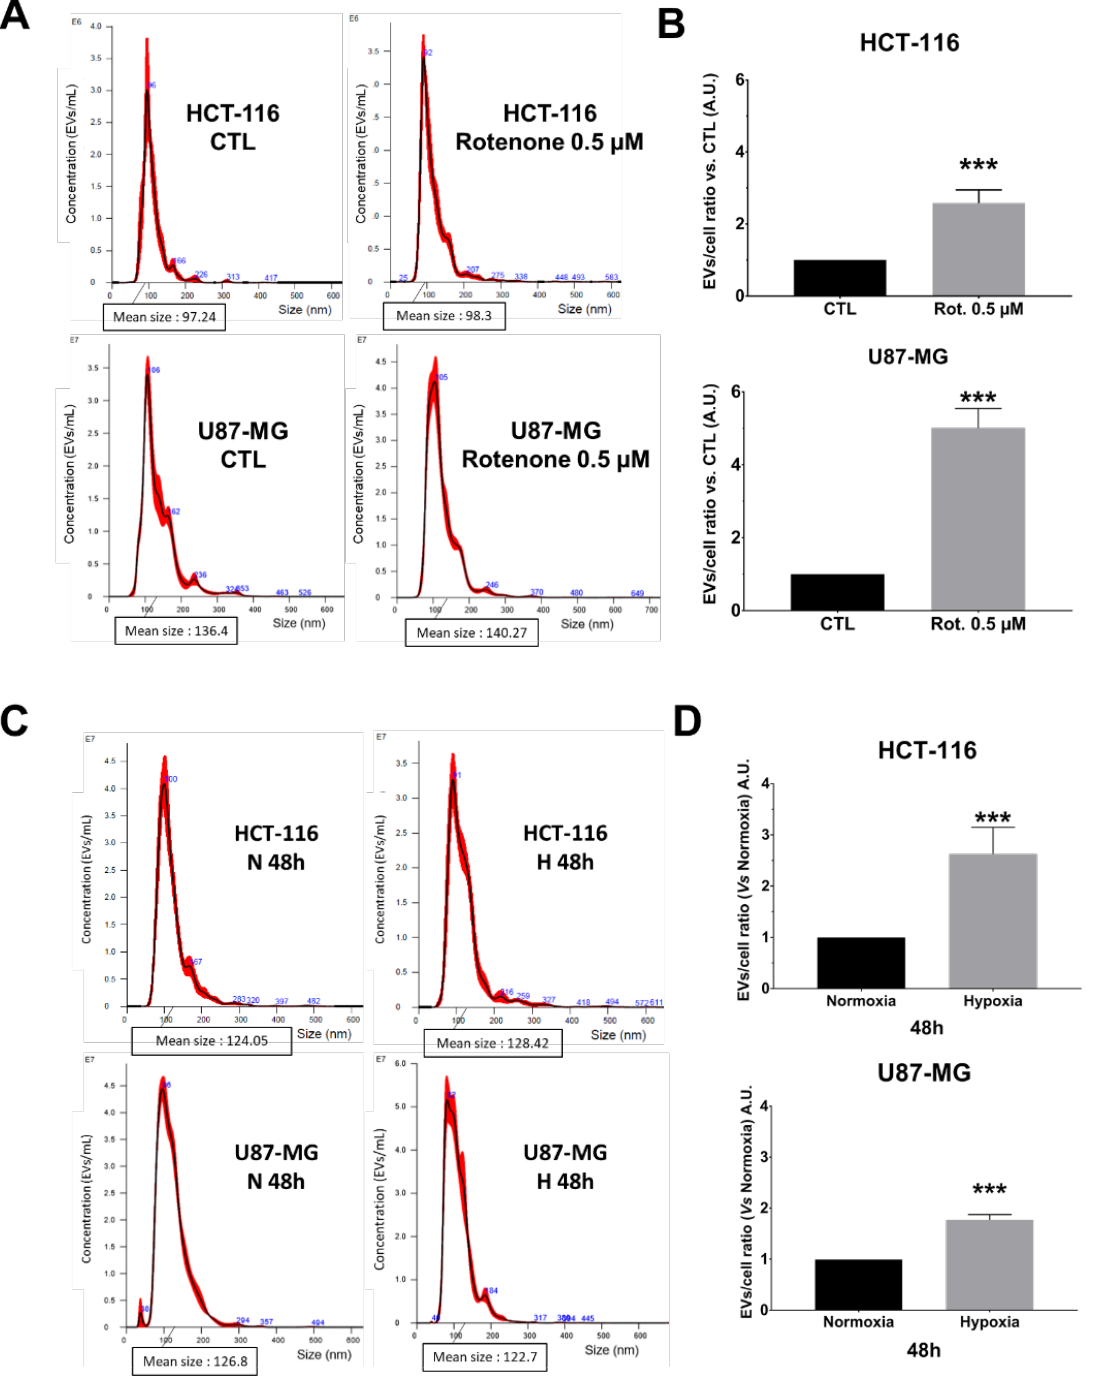
Figure 4. NTA analysis following EVs secretion increase attempts in HCT-116 and U87-MG cell lines. ( A )—Evaluation of the size repartition of the EVs secreted by the HCT-116 (upper panel) and U87-MG (lower panel) untreated pLKO (CTL) or treated with 0.5 µ M of rotenone for 48 h. ( B )—EVs/cell ratio was calculated for each condition in both HCT-116 and U87-MG cells ( n = 3 each). The Mann–Whitney test was performed in three independent experiments; p < 0.05 was considered significant. ( C )—EVs size range after 48 h under normoxia (N) or hypoxia (H) conditions was determined for both HCT-116 and U87-MG cells. ( D )—EVs/cell ratio was calculated for each cell line in hypoxia compared to normoxia conditions. The Mann–Whitney test was performed in three independent experiments; *** p < 0.001.